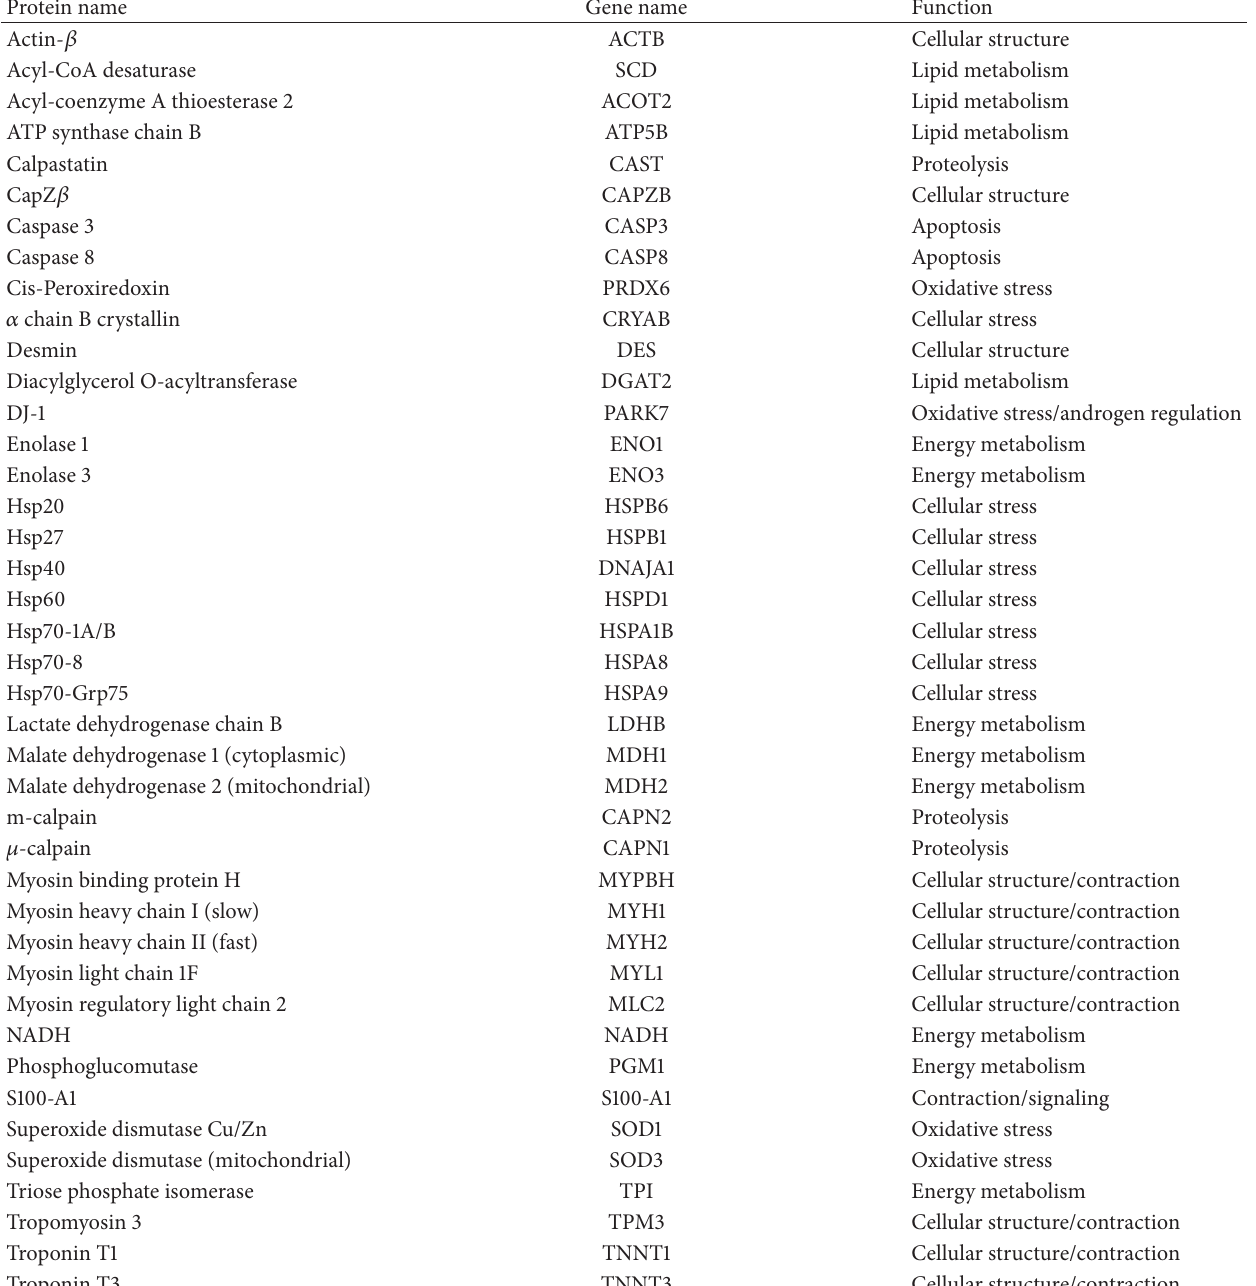
Table 1: List of proteins and gene identified to be associated with beef tenderness by transcriptomic and/or proteomic analyses according to [9,